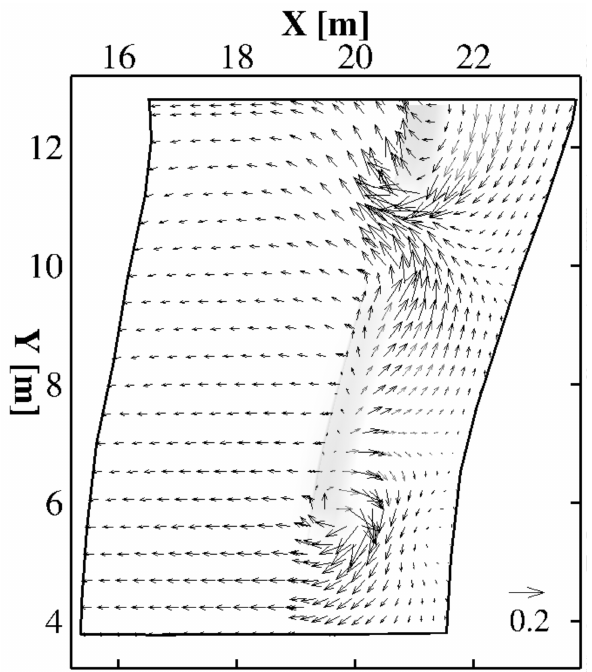
Figure 9. Case 1: Plan view detail of the time averaged (over 120 wave periods) velocity field. Only one out of every four vectors is